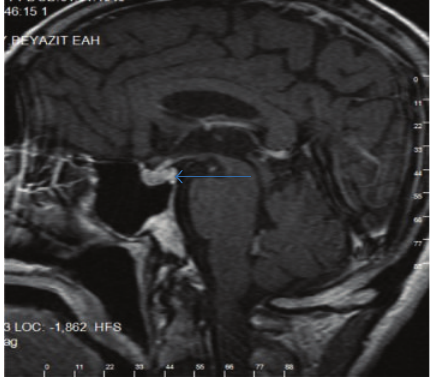
Figure 1: Bone scan: all bone metastases—rib, femur, pelvis, spine bone metastases.